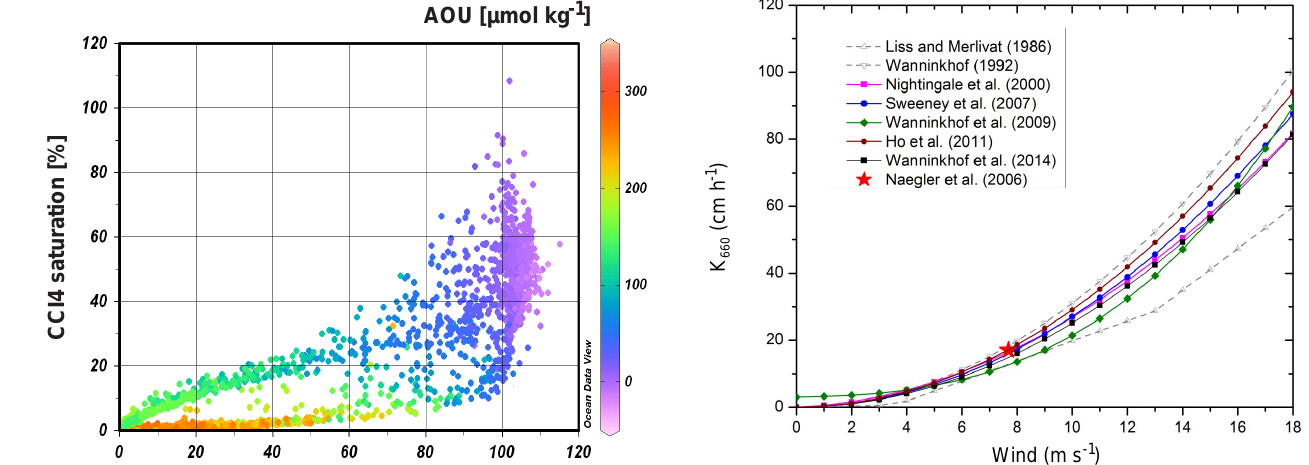
Figure 7. Measured saturations of CCl 4 and CFC-12 in sub-surface waters during the P18 cruise in the eastern Pacific as a function of Apparent Oxygen Utilization (AOU). Each point represents a single sample extracted from a Niskin bottle and analyzed by electron- capture gas chromatography. Points are colored according to the AOU in each measured sample.